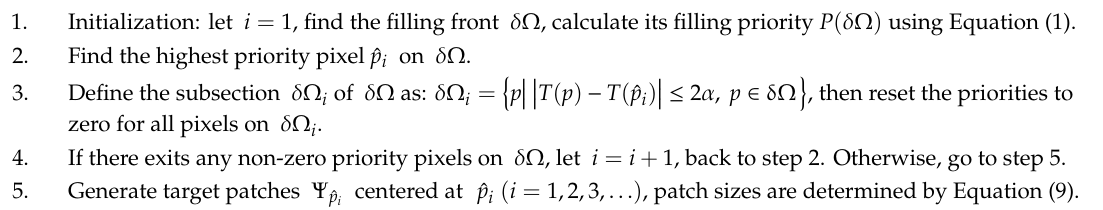
Algorithm 1. Determination of Multiple Target Patches on Filling Front.